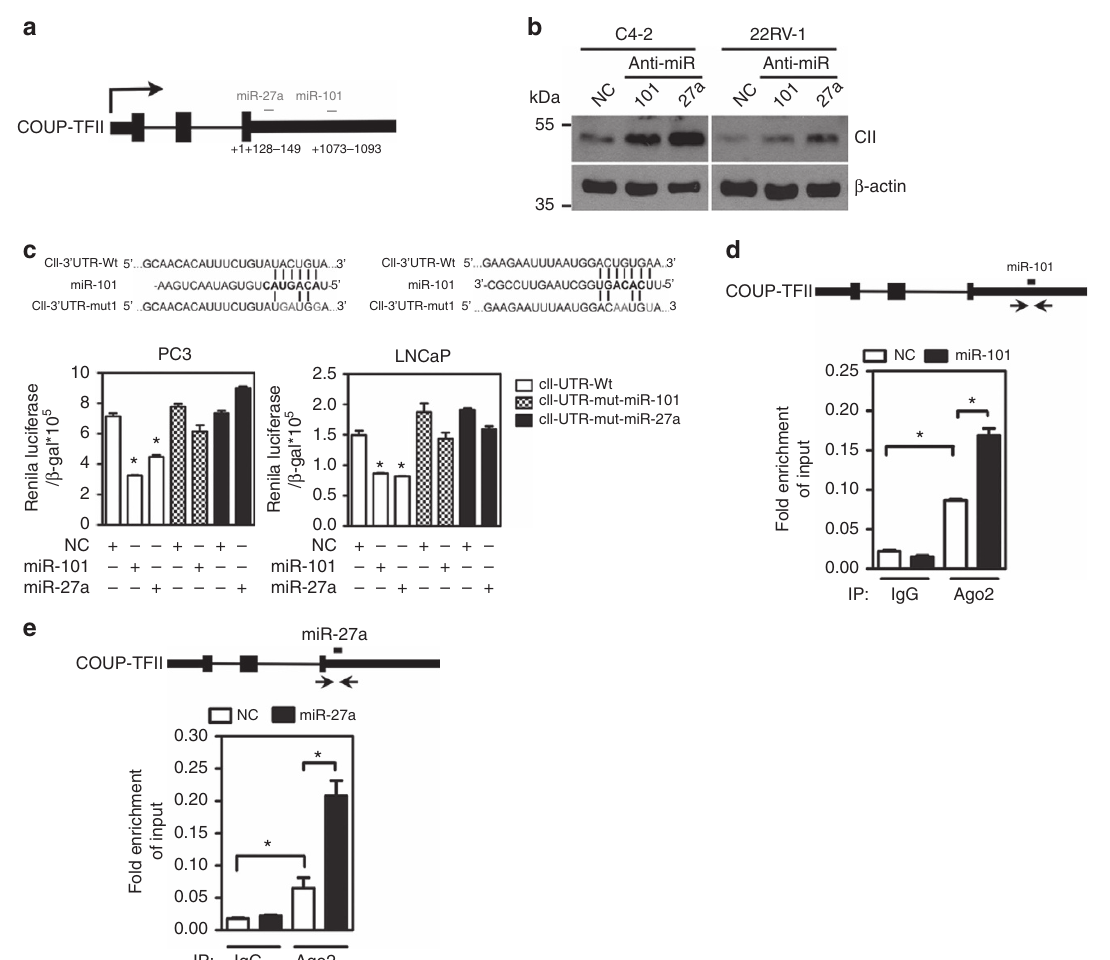
Figure 2 | The expression of COUP-TFII is repressed by miR-101 and miR-27a. ( a ) Cartoon indicates the recognition sites for miR-101 and miR-27a. ( b ) Representative western blot demonstrated the levels of COUP-TFII in 22RV-1 cells treated with inhibitors of miR-101 and miR-27a for 72h. ( c ) WT- and mutated- miR-101 and miR-27a recognition sites are shown in the upper panel. COUP-TFII 3 0 -UTR promoter activity was performed in LNCaP and PC3 cells overexpressing miR-101 and miR-27a mimics for 48h ( n ¼ 3). * P o 0.05 (two-sided Student’s t -test) compared with the NC (scramble control) group. ( d , e ) A cartoon shows location of primers in the COUP-TFII 3 0 -UTR region (upper panel). Levels of COUP-TFII 3 0 -UTR regions containing miR-101 and miR- 27a-binding sites that were immunoprecipitated with Ago2 or IgG antibody from PC3 cells after being treated with miR-101 ( d ) or miR-27a ( n ¼ 3). ( e ) mimic for 72h. * P o 0.05 (two-sided Student’s t